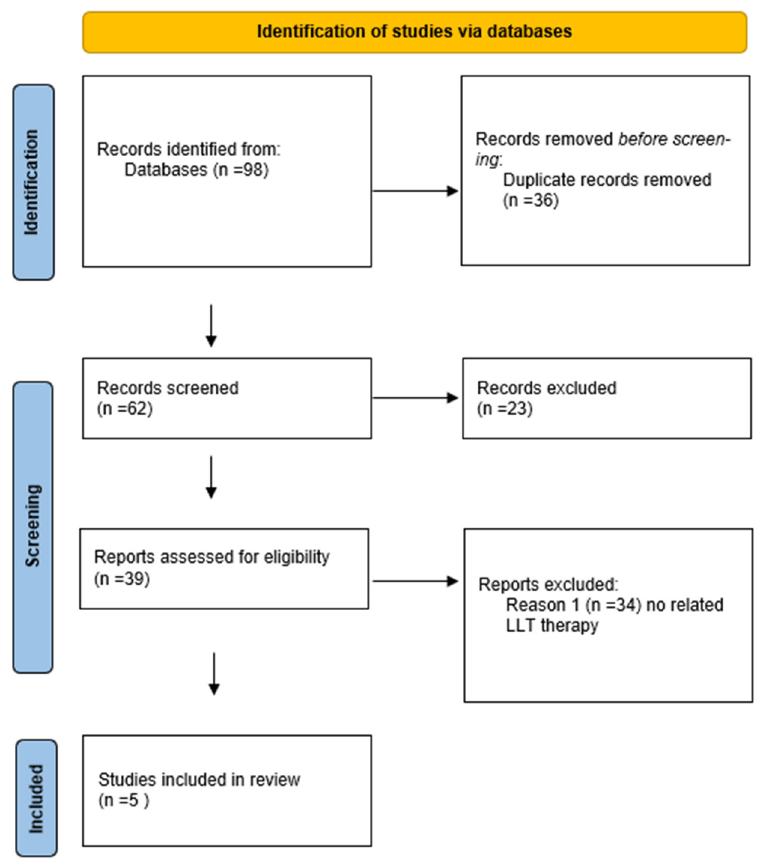
Figure 1. Flowchart of the screening.